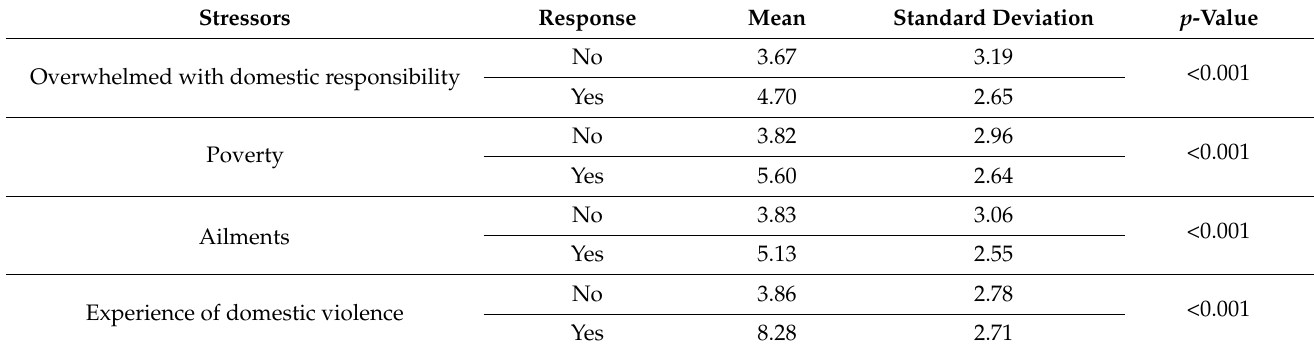
Table 3. Known Group Validity showing Association between CIDT-MD and Perceived Cause (Psychosocial Stressors).